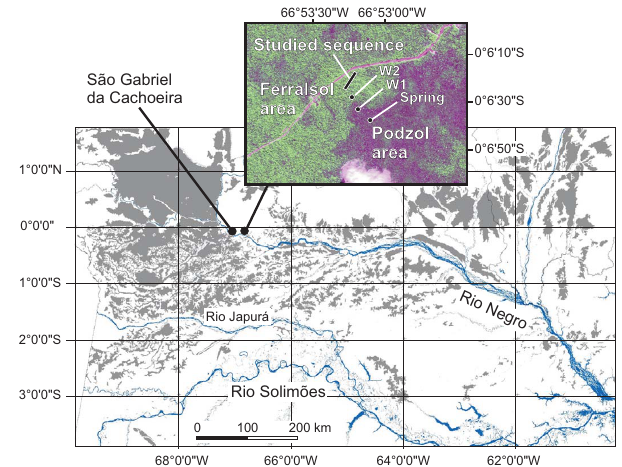
Fig. 1. Situation of the studied catena and extension of highly pod- zolic areas (in grey) in the Rio Negro basin. Compilation of highly podzolic areas was realized from digitalized soil maps of Amazonia (IBGE, 2009). The detailed view of the study area is issued from IKONOS imagery. The darker forested area corresponds to closed, low forest over hydromorphic podzols. W2 and W1 are sampling points outside the